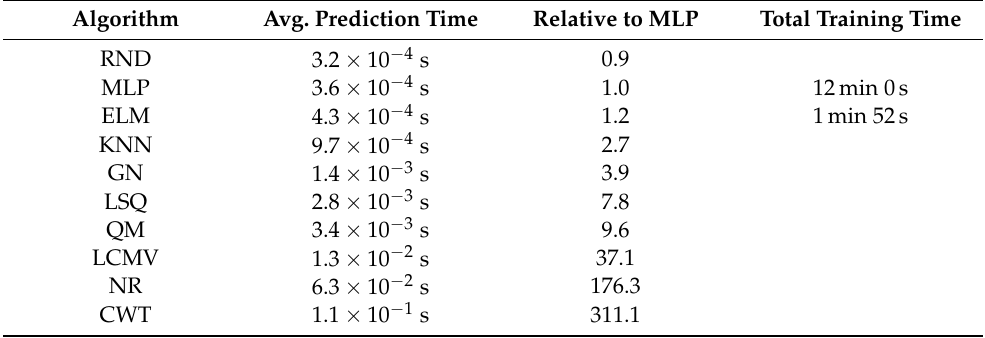
Table 3. Training and prediction time measurements of all dipole localisation algorithms. The (x + y) sensor configuration was used combined with the largest training and optimisation set D s =